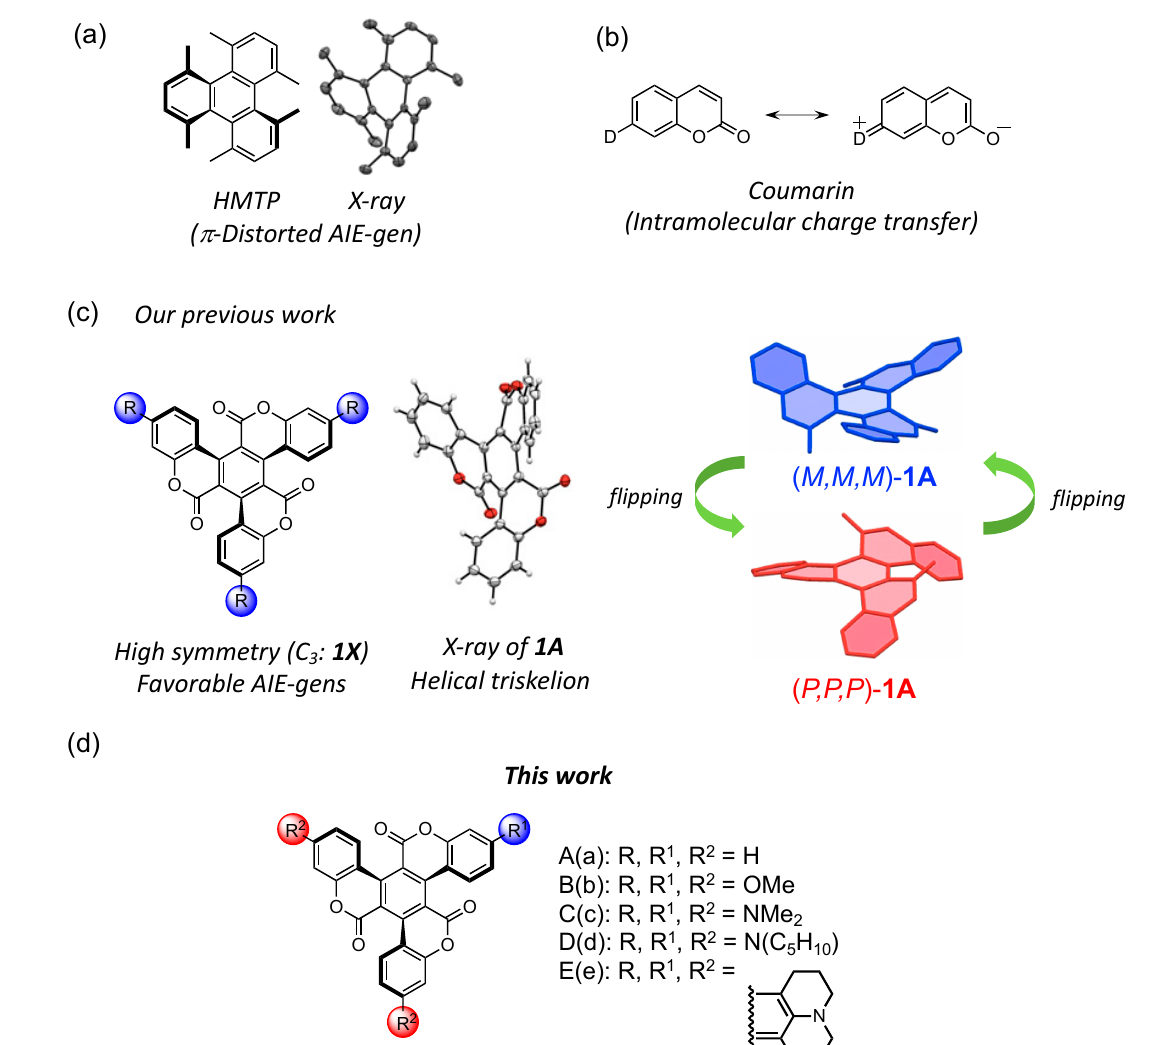
Figure 1. ( a ) Chemical structures of 1,4,5,8,9,12-hexamethyltriphenylene (HMTP). The X-ray structure of HMPT is shown [4,5]; ( b ) resonance structure of coumarin; ( c ) chemical structure of C 3 symmetric triskelion 1 and molecular structure of 1A ; ( d ) chemical structures of asymmetric triskelion-shaped target compounds.